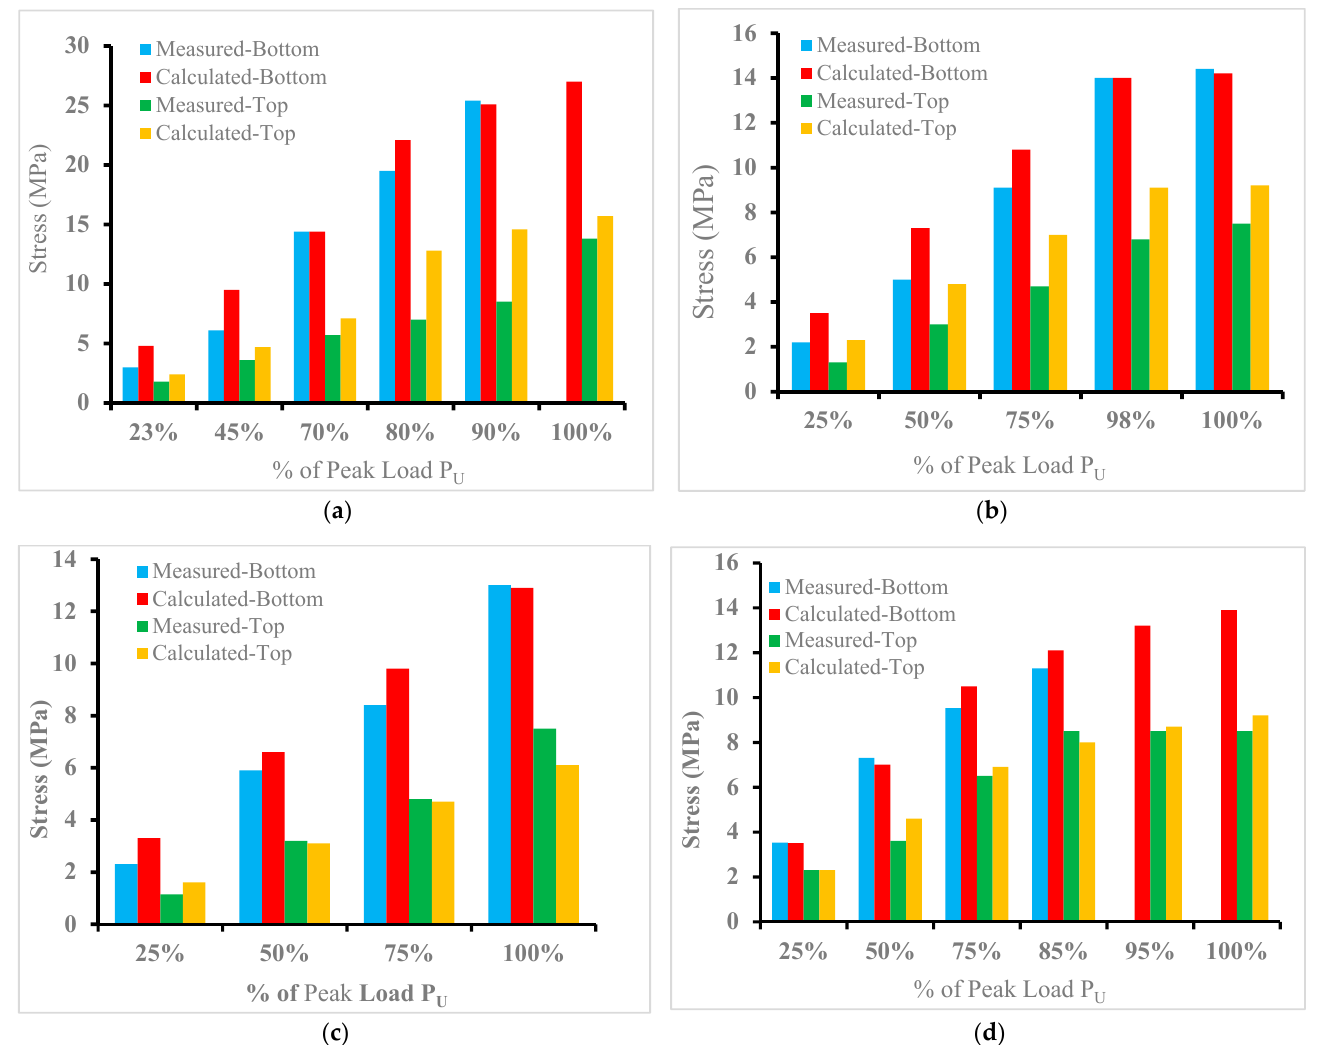
Figure 17. Measured and calculated stresses for selected load levels: ( a ) beam A20, ( b ) beam B20, ( c ) beam D25, and ( d ) Beam D50.